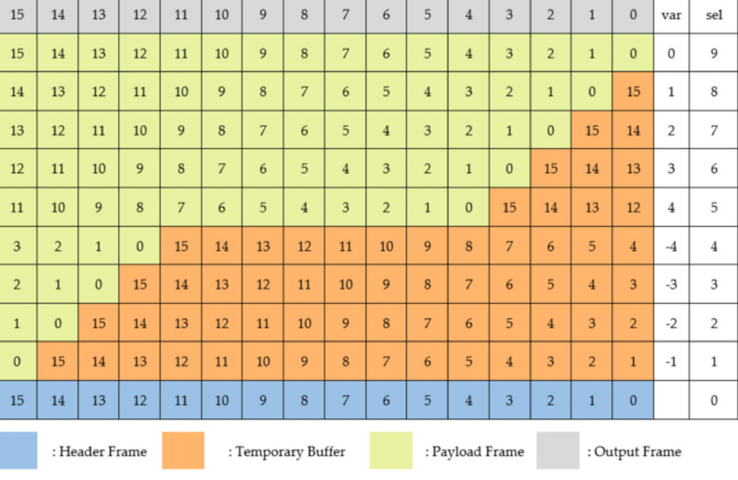
Figure 5. Select table for concatenated